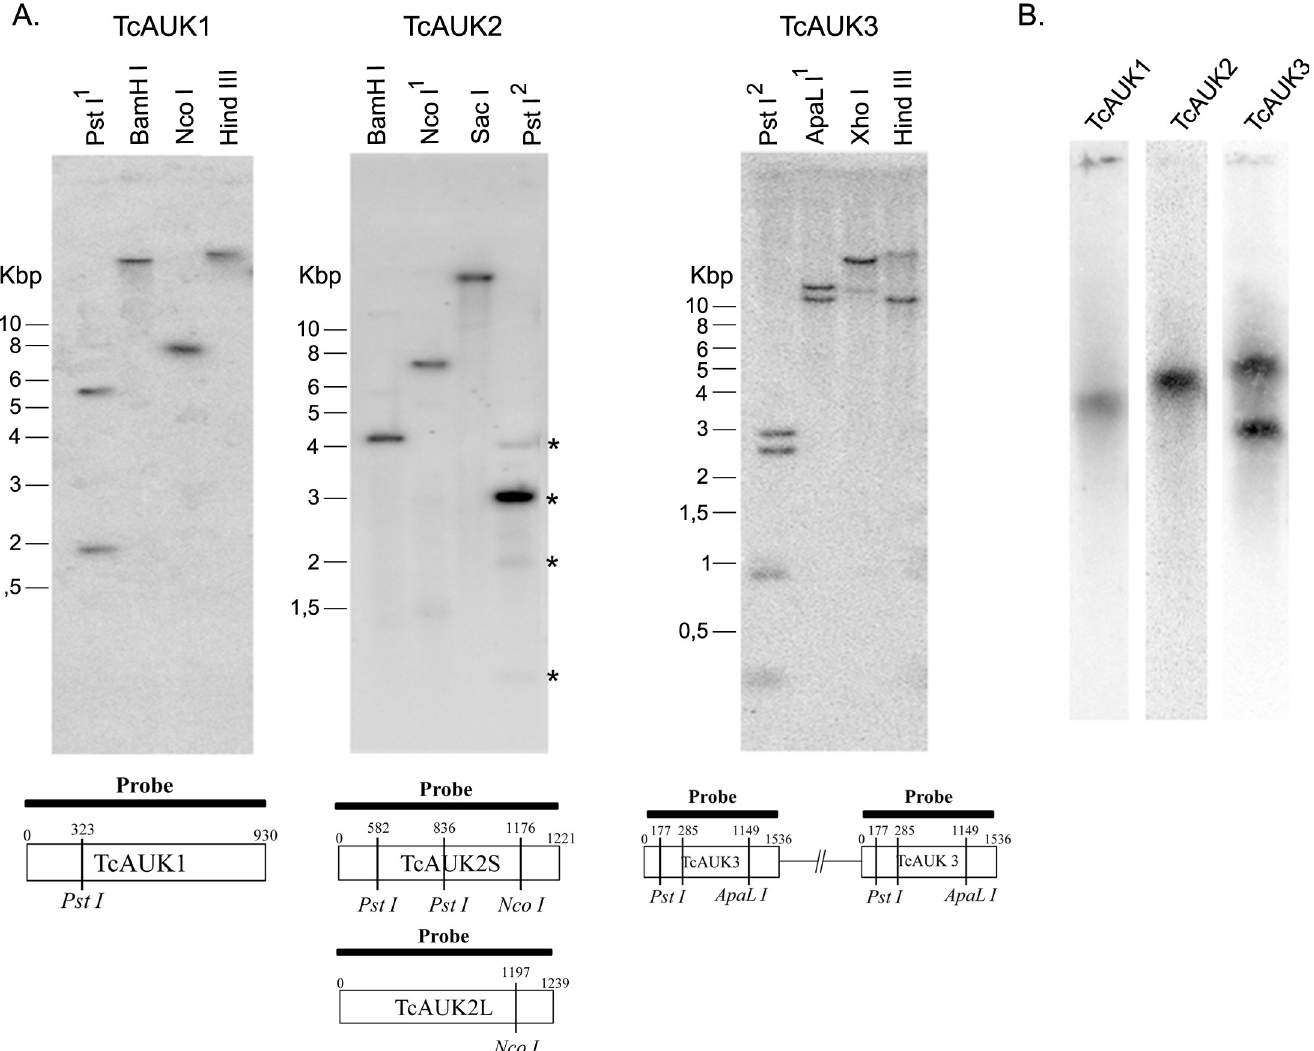
Fig 2. Genomic organization of TcAUKs genes. (A) Southern blot with TcAUKs probes and genomic DNA of T . cruzi digested with restriction endonucleases with target sites outside the TcAUK genes, and with one (1) or two (2) restriction site inside the sequence of the corresponding TcAUK gene. Asterisks at PstI line indicate the four obtained bands. (B) Pulsed Field Gel Electrophoresis (PFGE) of T . cruzi epimastigotes probed against each one of the TcAUK